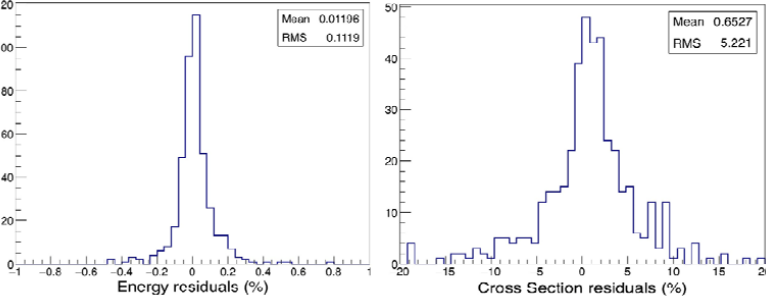
Fig. 4. Statistics of the energy and cross section values of the resonance peaks, taken as the differences between evaluation and experiments in percent. 3.1 Main findings The high degree of coincidence found between the Paradela data at CERN-nTOF and those of Weston at ORNL is confirmed by other high-resolution datasets. More than 280 peaks have been unambiguously identified, distributed as follows: 70 from 3 to 5 keV; 73 from 5 to 8 keV; 56 from 8 to 13 keV; and 82 from 13 to 30 keV. The position in energy of these points is statistically distributed with a RMS of 1.1 % (Fig. 3-left). In a recent paper of G.F. Bertsch et al. [20] the authors examine the autocorrelation function of the 235 U(n,f) reaction with a view to quantify the presence of intermediate structures in the cross section. Finally they claim that the apparent fluctuations due to compound nucleus resonances, on the order of the eV energy scale, do not present structure but in the region around 20 keV. They based the study mainly in the Perez data from ORNL [21], discarding among others the Weston data, with the argument that the Perez dataset has a superior energy resolution, what it is false in the range below 30 keV (from the information available in EXFOR). This bad choice is leading us to criticize the Bersch assertion. In Fig. 5 is presented the smoothed USC-Eval which suggests the existence of correlated peaks on the scale of 1 keV, that have the same profile as the 22 keV structure analysed in [20]. That structure shape can be suspected around 9 keV, 15 keV, and 19 keV, for instance. The existence of narrowest structures is also suggested below 9 keV in the plots presented in Fig.